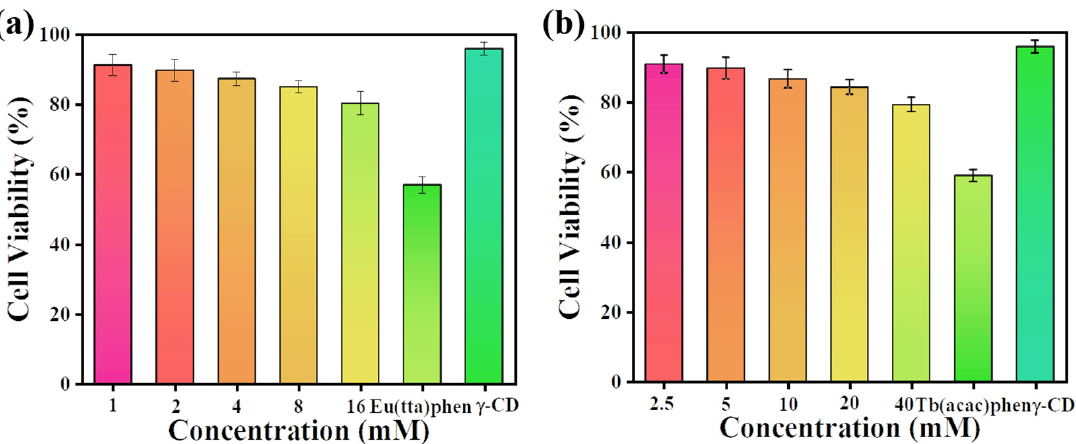
Figure 8. ( a ) Cell metabolic activity after incubation with Eu(TTA) 3 phen, γ -CD, and different concentrations of ECA for 24 h. ( b ) Cell metabolic activity after incubation with Tb(acac) 2 phen, γ -CD, and different concentrations of TCA for 24 h. Error bars represent standard deviation from n = 5 biological replicates for each condition.